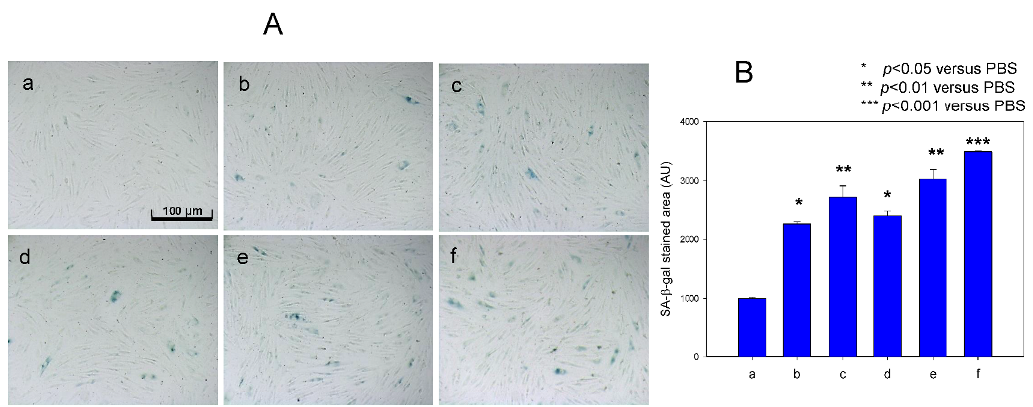
Figure 6. Induction of cellular senescence in human dermal fibroblasts (HDFs) under presence of Fe 2+ by comparison of Senescence-associated β -galactosidase (SA- β -gal) staining. Cells were treated with or without fructose for 15 days (at passage = 13). ( A ) Cell image was captured using a Nikon Eclipse TE2000 microscope (Tokyo, Japan) at 600 × magnification. Photo a, PBS-treated; Photo b, 60 µ M Fe 2+ (final)-treated; Photo c, 120 µ M Fe 2+ (final)-treated; Photo d, PBS + fructose (final 5 mM); photo e, fructose (final 5 mM) + 60 µ M Fe 2+ (final); photo f, fructose (final 5 mM) + 120 µ M Fe 2+ (final)-treated. ( B ) Graph shows percentage of SA- β -gal-positive cells per 7.4 mm 2 of cell culture area during Fe 2+ treatment to human dermal fibroblast (HDF) cells. ***, p < 0.001; **, p < 0.01; *, p <